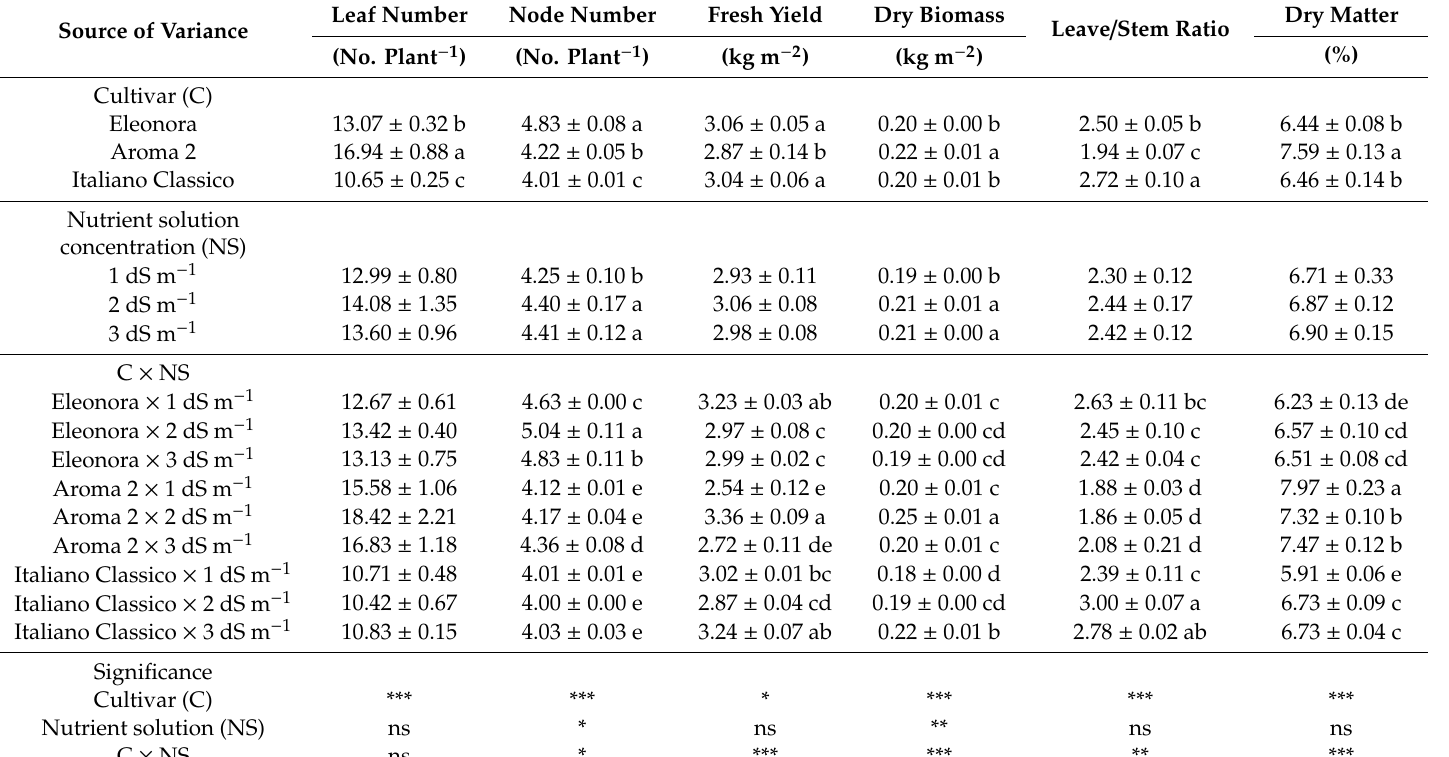
Table 1. Sweet basil biometric parameters in light of the cultivar and the nutrient solution electrical